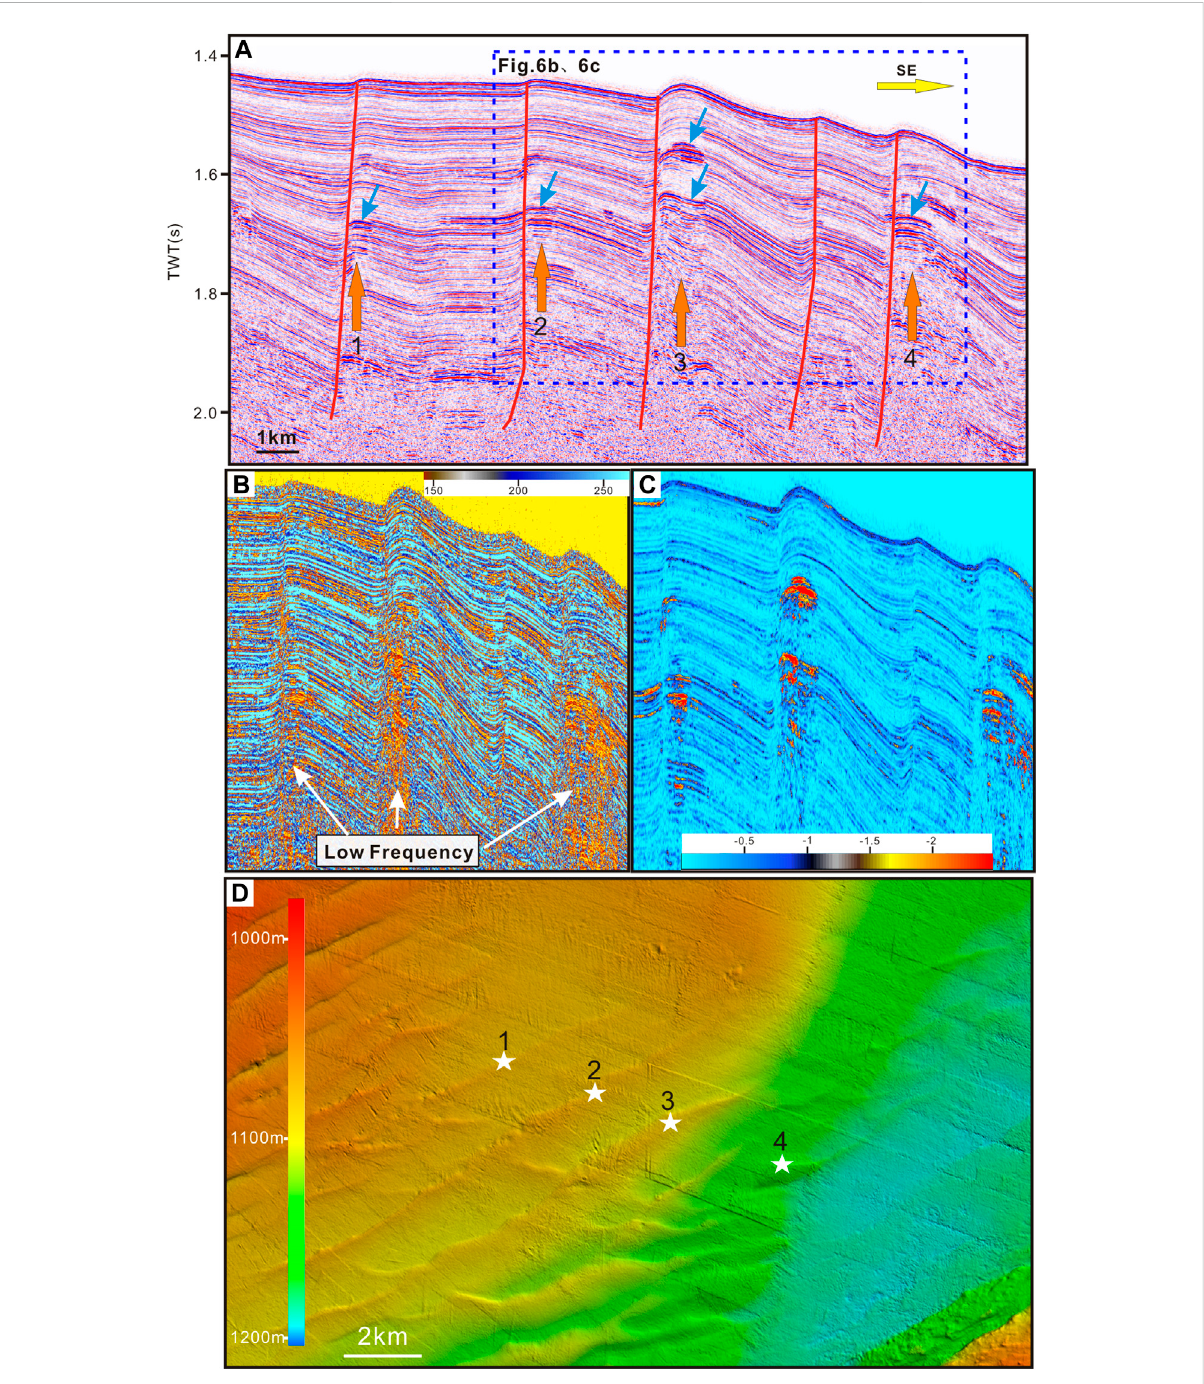
FIGURE 6 Type-C seismic chimneys. (A) The seismic pro fi le shows type-C chimneys; (B) The Instantaneous frequency attribute pro fi le; (C) The high- frequency attenuation attribute pro fi le. The location of (B) ; (C) is shown in Figure 6A. Low-frequency and high-frequency attenuation anomalies are all reveal the presence of fl uids. (D) Multibeam bathymetry data reveal the relationship between chimneys and faults. White pentacles represent corresponding chimneys in Figure 6A. See locations in Figure